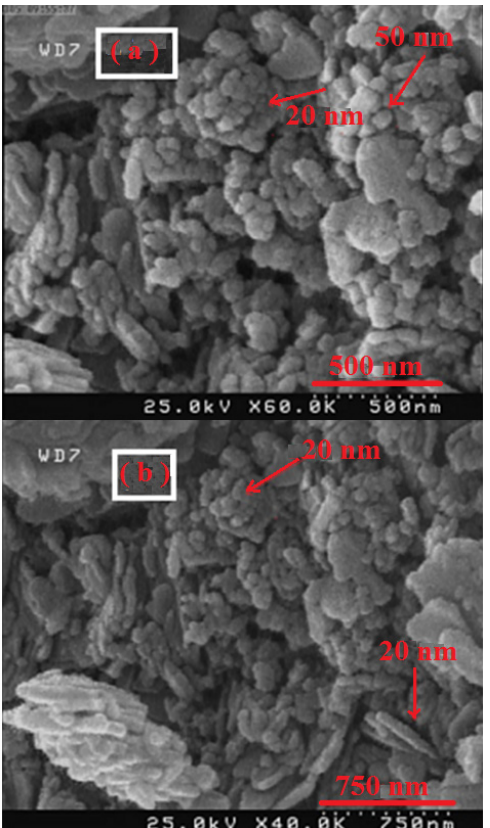
Fig. 2 SEM images of (a) bare zeolite, (b) modified zeolites. Fig. 2: SEM images of (a) bare zeolite, (b) modified zeolites.